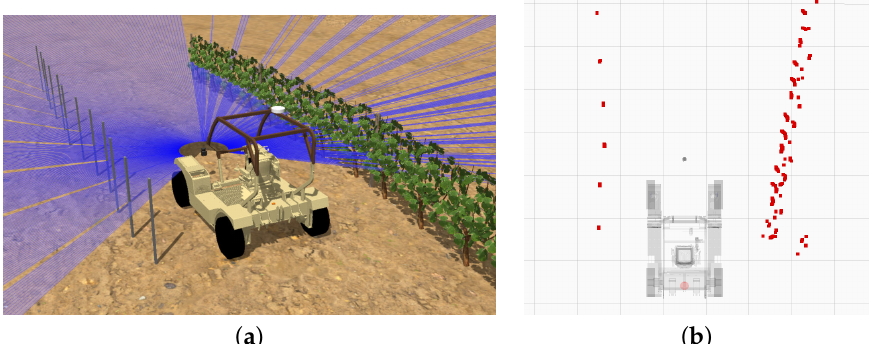
Figure 3. Placement of the horizontal 2D Lidar on the robot. The measurements of the sensor are converted into 2D points in the robot frame. ( a ) Visualization of the Lidar rays (in blue); ( b ) 2D projection of the Lidar